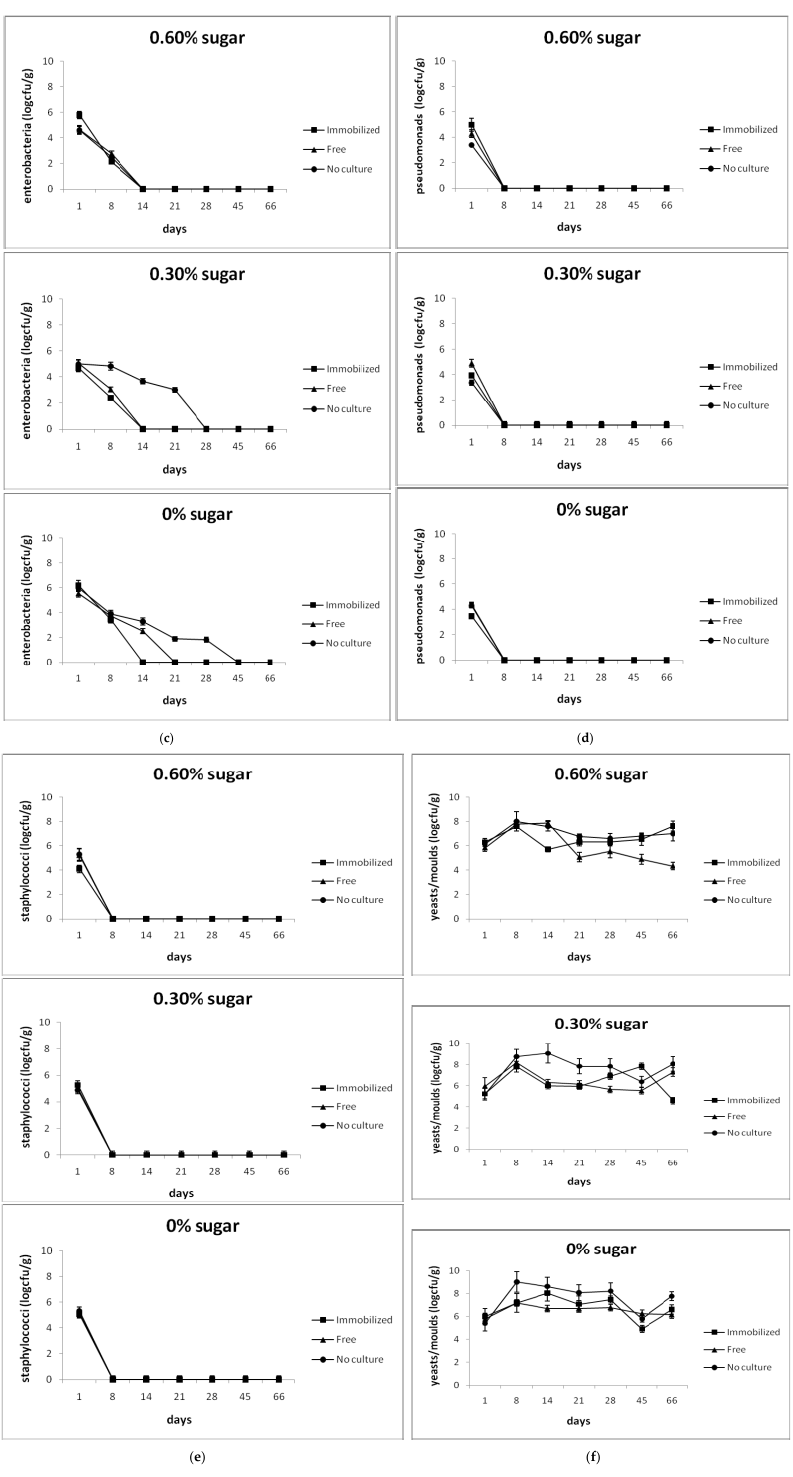
Figure 2. Effect of sugar addition and probiotic starter culture on microbial association during ripening of dry-fermented sausages : ( a ) total aerobic counts, ( b ) lactobacilli, ( c ) enterobacteria, ( d ) pseudomonads, ( e ) staphylococci and ( f ) yeasts/moulds. Points at zero represent levels below the detection limit (<1.50 log cfu/g for enterobacteria and <2.50 log cfu/g for pseudomonads and staphylococci). Error bars indicate standard deviations ( n = 3).